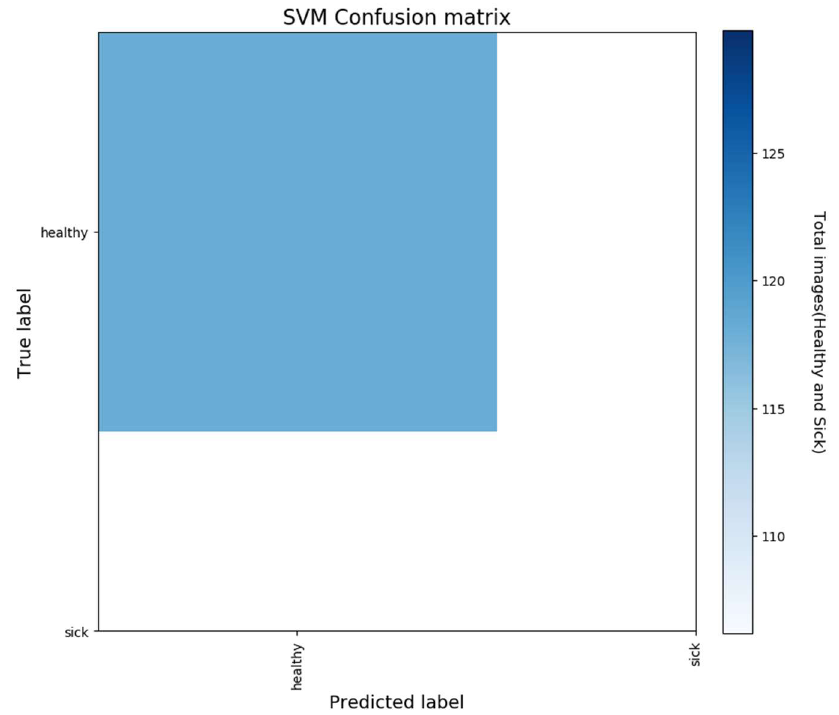
Figure 14. Confusion Matrix of our LinearSVC (SVM) shows how confident our classifier is for each prediction.